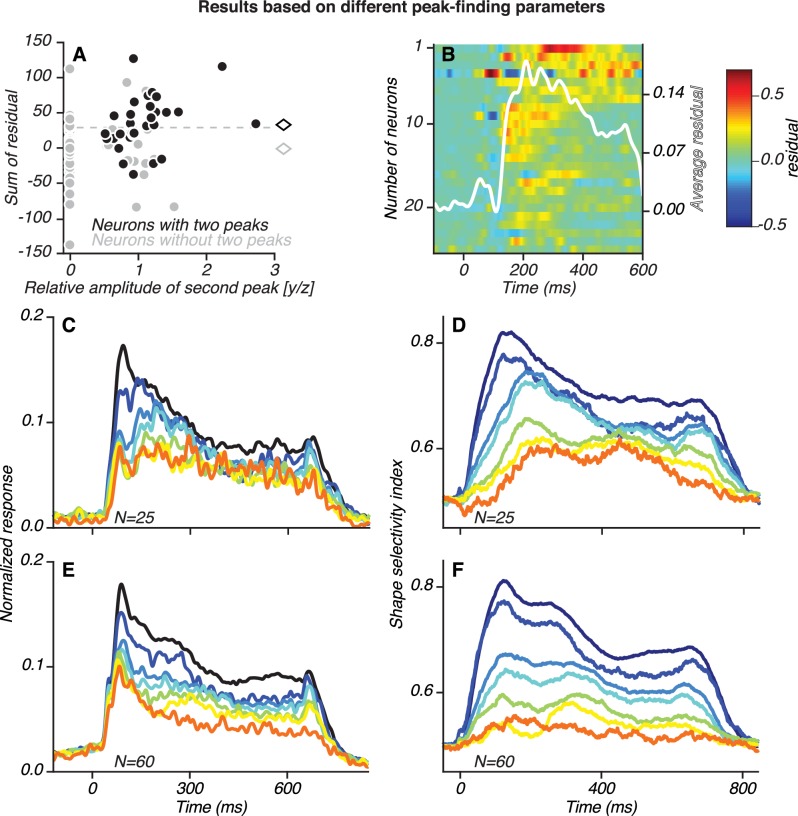
Population results for neurons with stronger responses to occluded stimuli than expected from linear scaling (see Figure 8—figure supplement 5).(A) Scatter plot of the sum of residuals (ordinate) derived from the predictions of the gain-modulation model versus the relative amplitude of the second peak (y/z, same as abscissa in Figure 8—figure supplement 3) for neurons with (black) and without (gray) two peaks. Neuronal classifications were based on the peak-finding algorithm. Of the neurons classified as having one transient response peak (gray), 43 neurons did not have a candidate second peak with a sizable amplitude and trough-to-peak modulation and are therefore assigned y/z = 0; 12 neurons that did have a candidate second peak with y/z > 0.5, did not pass the statistical criterion. We fit the linear gain-modulation model as described in Figure 8—figure supplement 5 and summed the residuals in the time window 45–600 ms after test stimulus onset, allowing for V4 response latency. For 43 neurons that had no candidate second peak in their responses, y/z = 0. For most neurons with two peaks (black dots), the sum of the residuals was >0. The average sum of residuals (diamonds) was significantly greater (t Test, p<0.05) for neurons with two peaks. (B) We examined the time course of the residuals for 25 neurons with the highest summed residuals, that is those neurons above the dashed line in (A). These are neurons with stronger responses to occluded stimuli than expected based on multiplicative scaling of the initial transient in response to unoccluded shapes. Of these 25 neurons, 17 were classified as having two peaks (by the peak-finding algorithm), a significantly greater proportion than expected by chance (Binomial test, p<0.01). The average residual across these 25 neurons (white line) reached a maximal value at 208 ms, close to the median time of the second peak (Figure 6C). (C–F) Population PSTHs and shape selectivity for the 25 neurons in B, showing similar results to those in Figures 6 and 8.